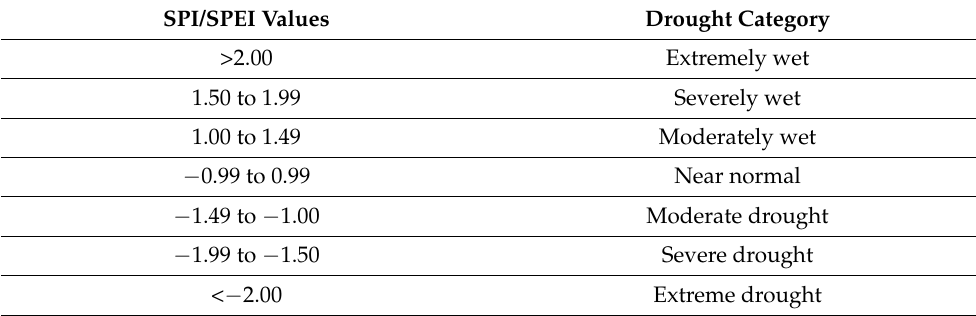
Table 1. Drought category classification by SPI and SPEI values